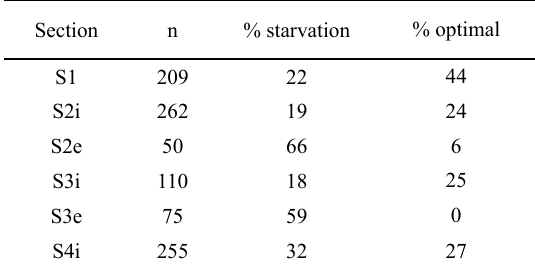
Table 4. – Percentage of Engraulis anchoita larvae in starvation (RD<CRD) and above optimal growth (Gpf>1) in each oceanographic section (S) grouping the internal (i) and external (e) stations in relation to the position of the tidal front (S1, S2i, S2e, S3i, S3e,